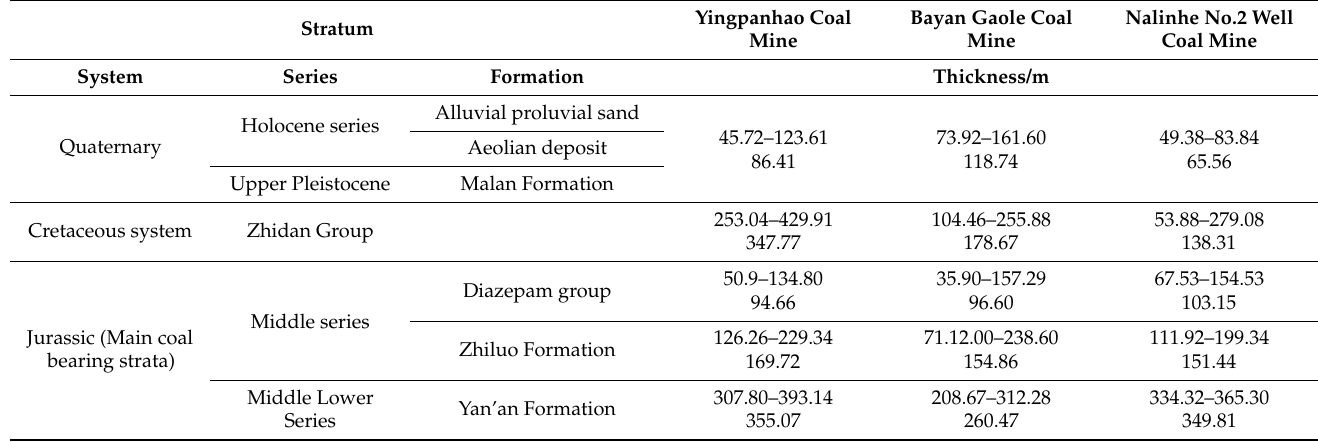
Table 3. Strata distribution of deep mining area in the part of Dongsheng coalfield.